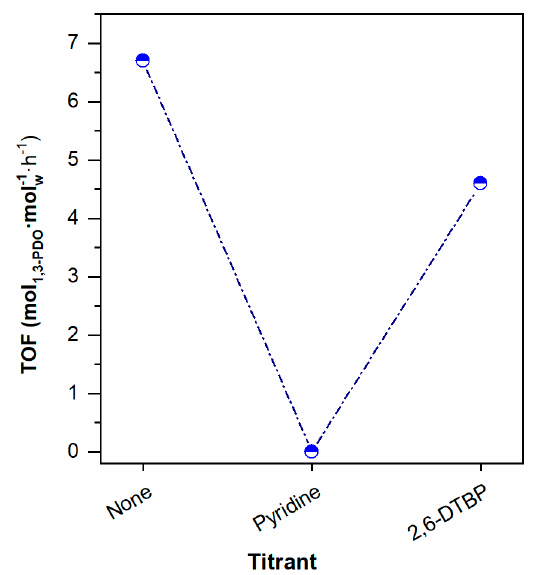
Figure 5. For the 10Pt pH10 15W* catalysts, effect of the presence of a titrant (i.e., pyridine or 2,6-di-tert-butyl-pyridine) in the TOF 1,3-PDO-W . Operating conditions: 473 K, 55 MPa H 2 , 5 wt.% glycerol water solution, 0.3 g cat ·g glycerol − 1 .